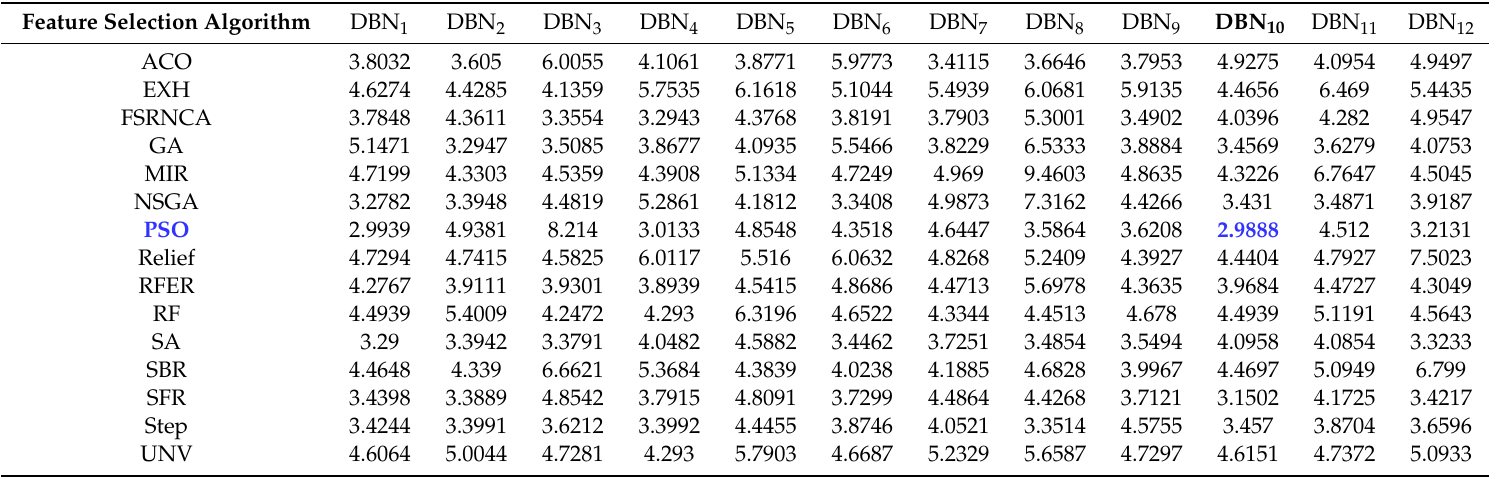
Table 3. The influence of feature selection algorithms on GSR prediction problems in terms of the relative root mean square ( RRMSE % ) generated by the deep belief network (DBN) model for a selected solar city, Adelaide (Australia) in the training phase illustrated as an example. The most optimal feature selection algorithm (i.e., PSO) and the relevant DBN model architectures (i.e., DBN 10 ) are highlighted in blue and is boldface